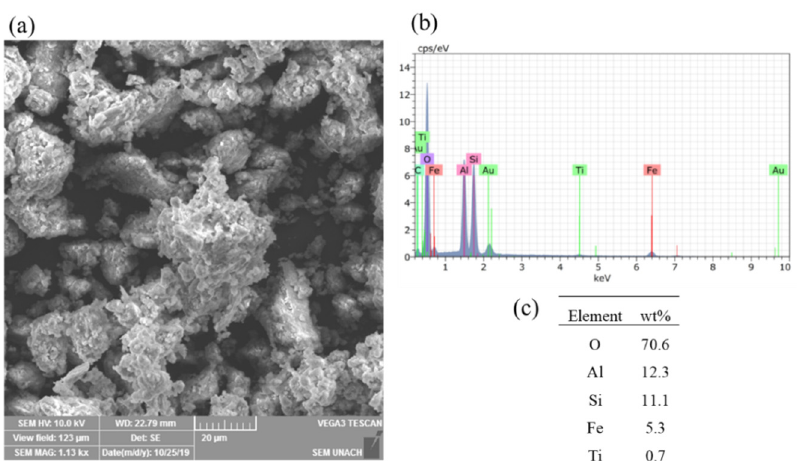
Figure 1. (a) Read clay micrograph. (b) Energy dispersive spectroscopy of x-ray photon of the total 178 Figure 1. ( a ) Red clay micrograph. ( b ) Energy-dispersive spectroscopy of X-ray photon of the total micrograph area. (c) Elemental composition. 179 micrograph area. ( c ) Elemental